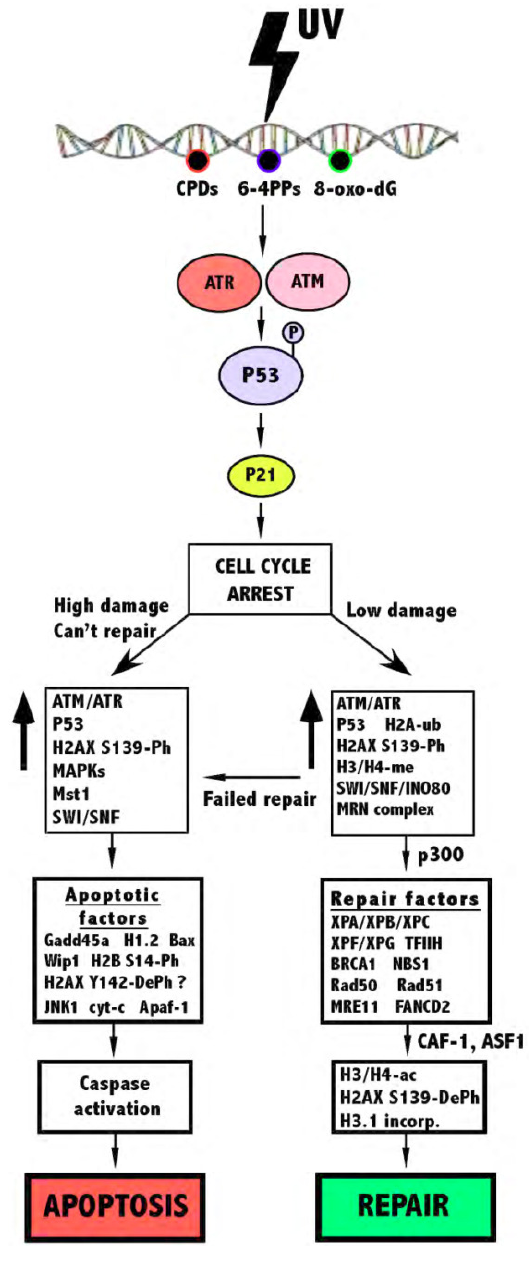
Figure 3. The effect of histones and activated enzymes post UV. P/Ph = phosphorylation, DePh = dephosphorylation, Ac = acetylation, Ub = ubiquitylation, Me = methylation. Upon UV-induced DNA damage, photoproducts are formed, triggering the ATM/ATR response, in turn phosphorylating P53 and activating P21, leading to cell cycle arrest. The amount of damage, as well as histone modifications and protein activation then determines the fate of the